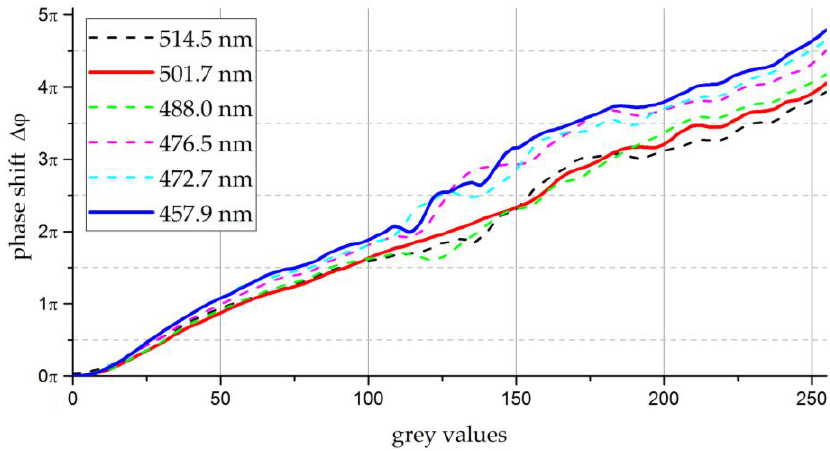
Figure 4. Calibration curves for the Holoeye PLUTO-VIS LCSLM for several lines of an Ar + -laser head, obtained by an “18-6” digital addressing sequence.